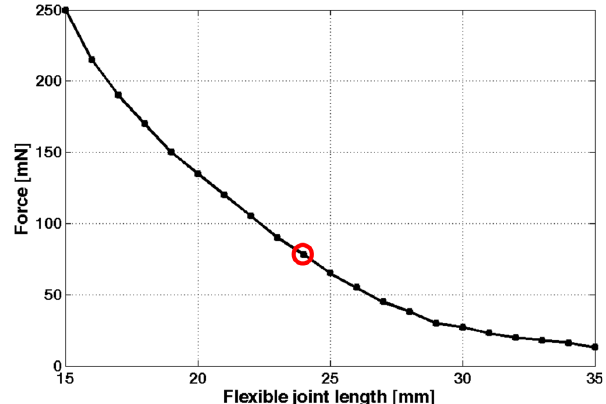
Figure 9. Trend line of the vertical magnetic attraction force be- tween the MLS external and donut-shaped magnets in equilibrium point (Fig. 2a-2). The dots represent the discrete FEM analysis re- sults. The red circle highlights the F m equal to F w for a 24mm L beam .